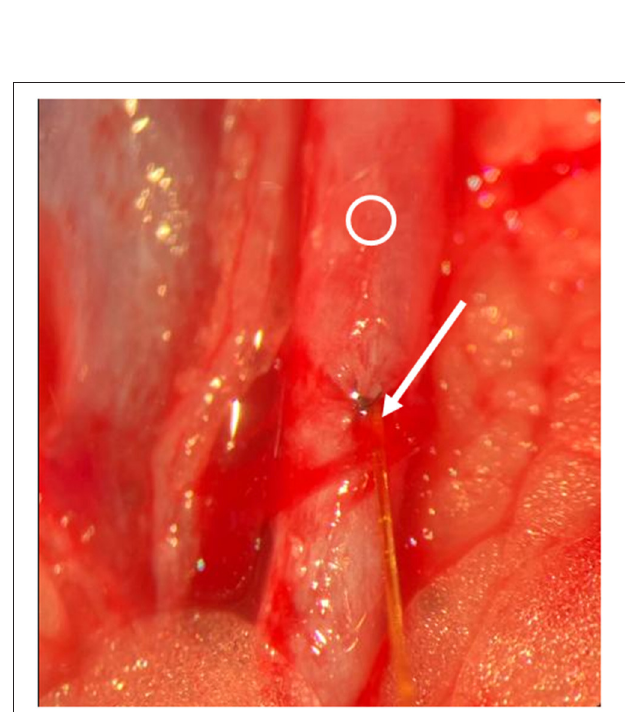
FIGURE 5 | Intraoperative situs. Blue clips are visible, Ring indicates vessel. Arrow indicates slot. Opening of the vessel.